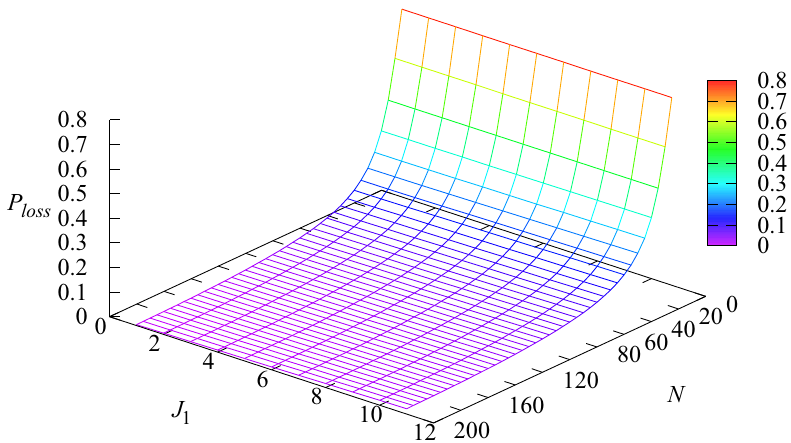
Figure 4. Dependence of the loss probability P loss on N and J 1 .